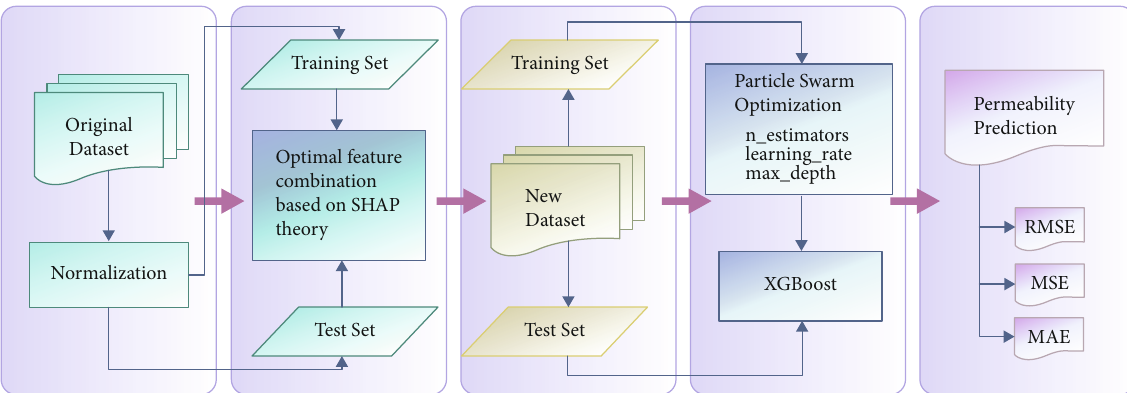
Figure 6: Modeling fl owchart for predicting